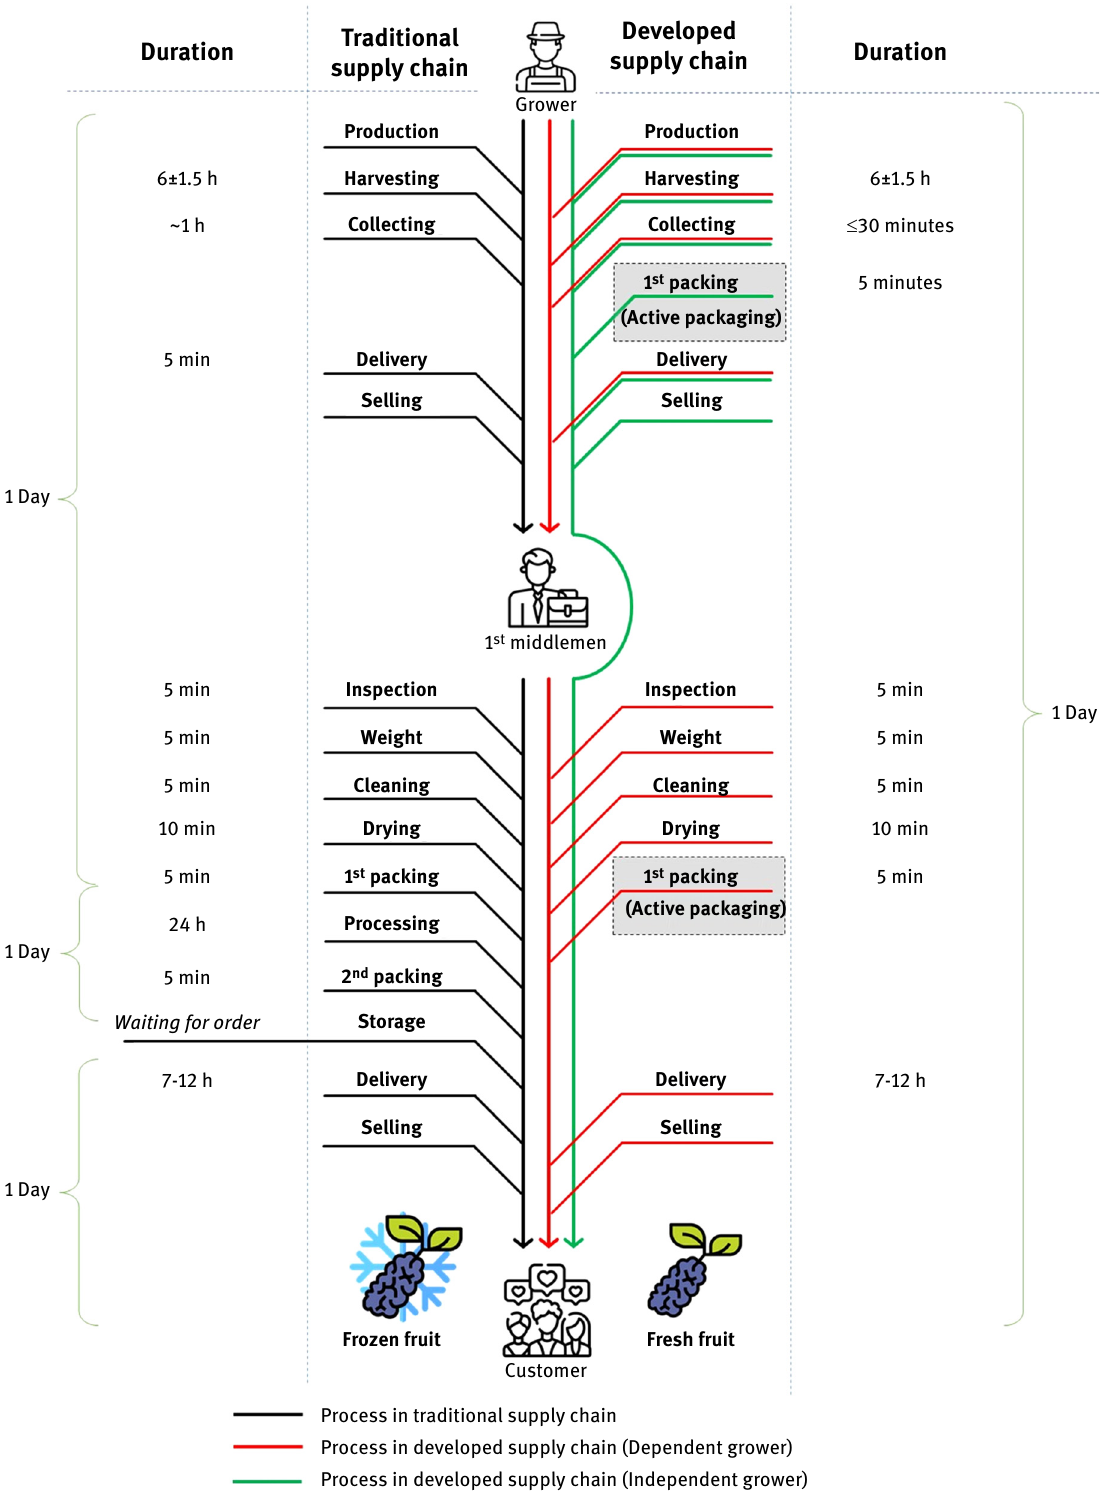
Figure 4: Production and post harvesting practices at the Phu Fa development